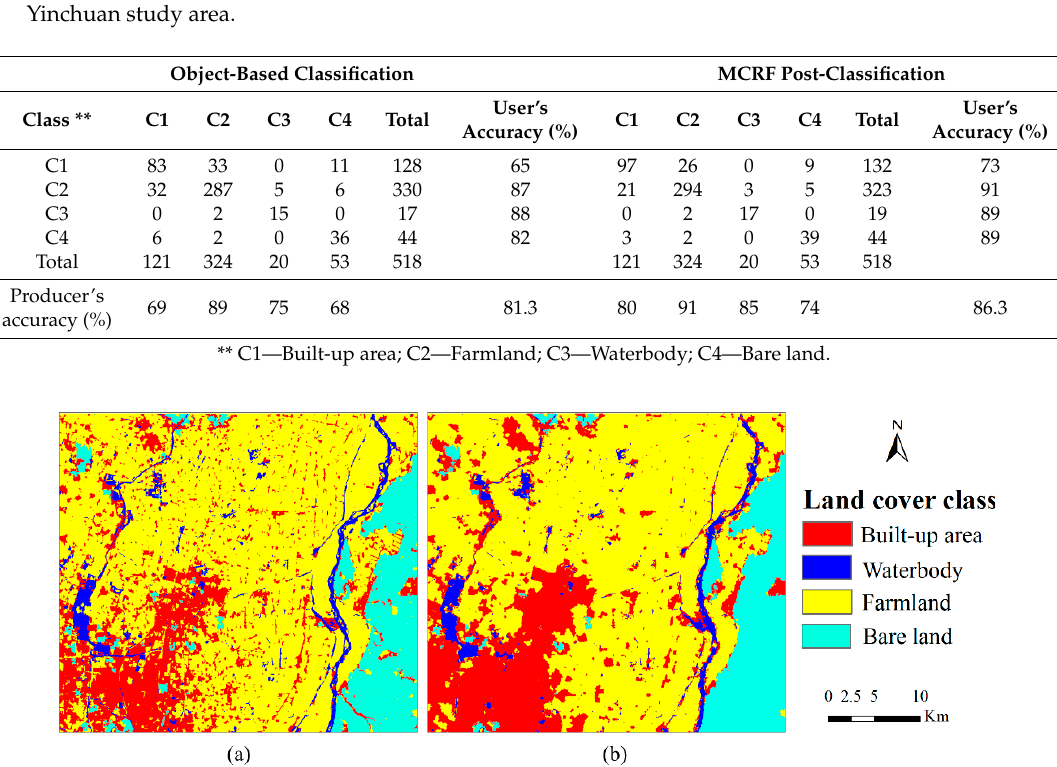
Figure 6. Land use/cover classification results for the Yinchuan study area: ( a ) pre-classification map; ( b ) MCRF post-classification.